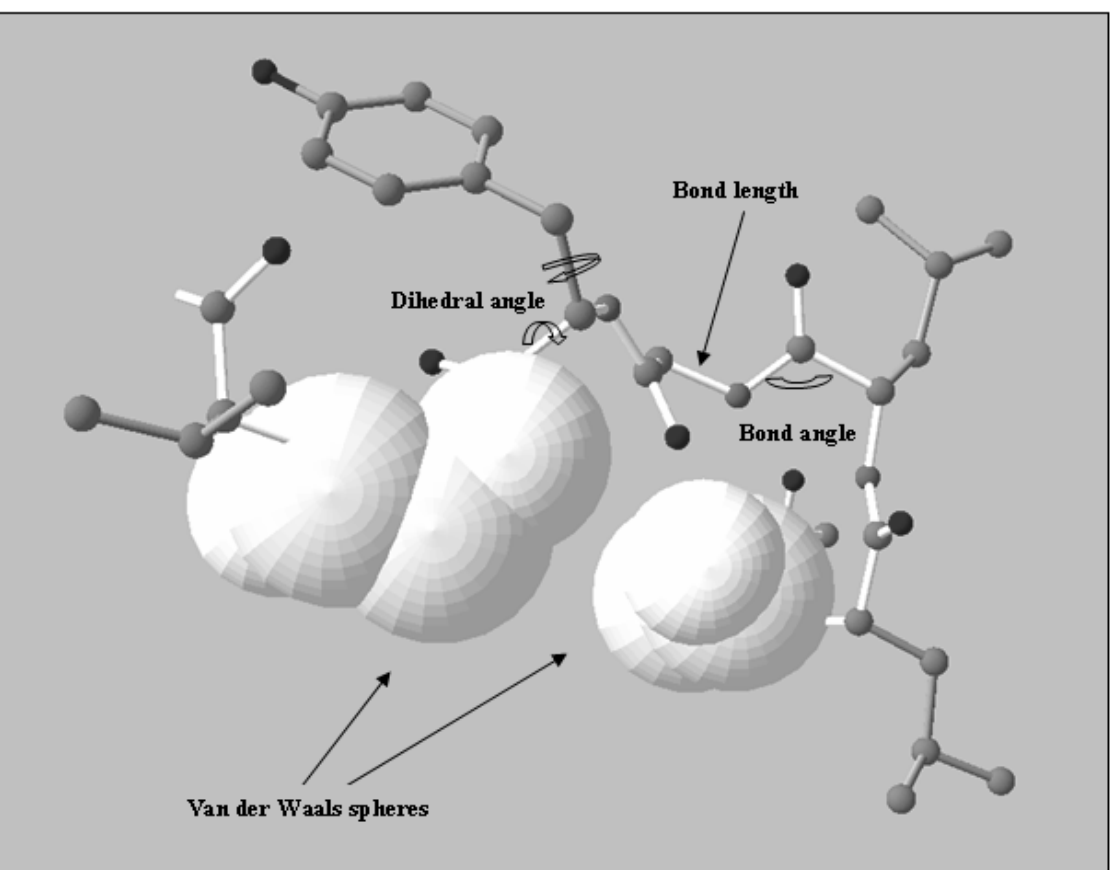
Figure 6: The peptide backbone is coloured in white, whereas the side chains are gray. Realistic values for bond length, bond angle and dihedral angles are determined from known structures. Steric interactions arise when the van-der-Waals spheres of two non bonded atoms are approaching and overlapping each other. The radius of the van-der-Waals sphere is defined as the distance at which the repulsive force begins to increase sharply. Through energy minimization configurations with physically realistic values of bond lengths, bond angles and dehidral angles are